Question: What visual encoding does this figure use to show its data?
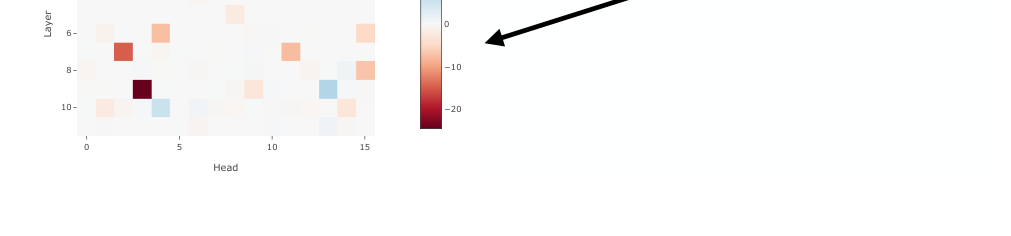
Answer: bar